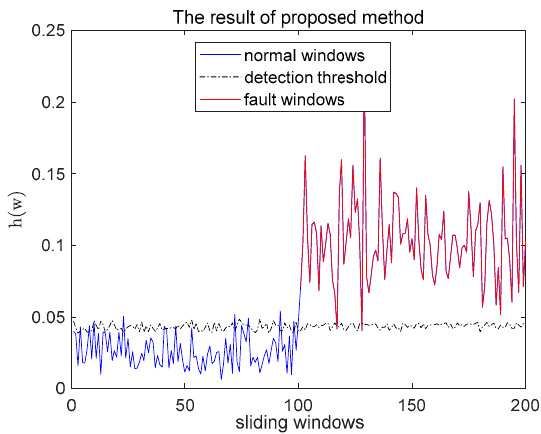
Figure 9. The detection result of the proposed method for the incipient fault f 3 .